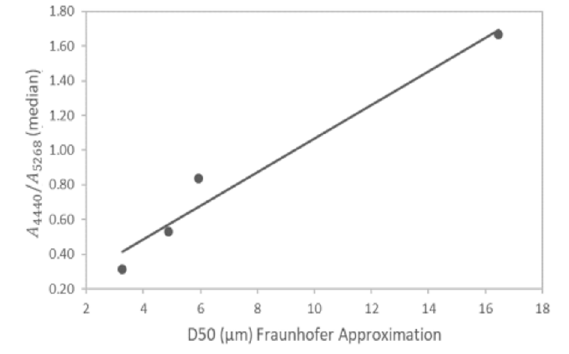
/A ) for silica 4440 5268